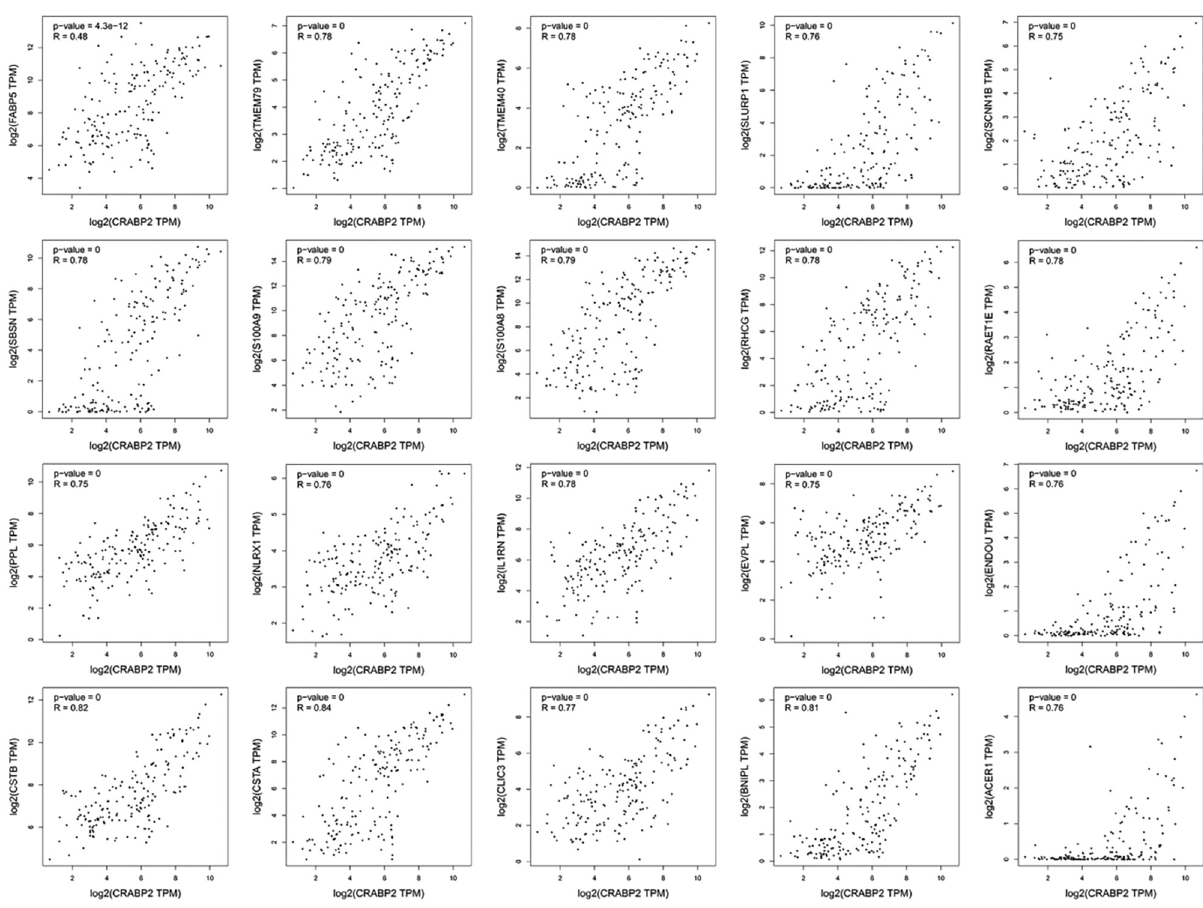
Figure 3: Correlation analysis between CRABP2 and each